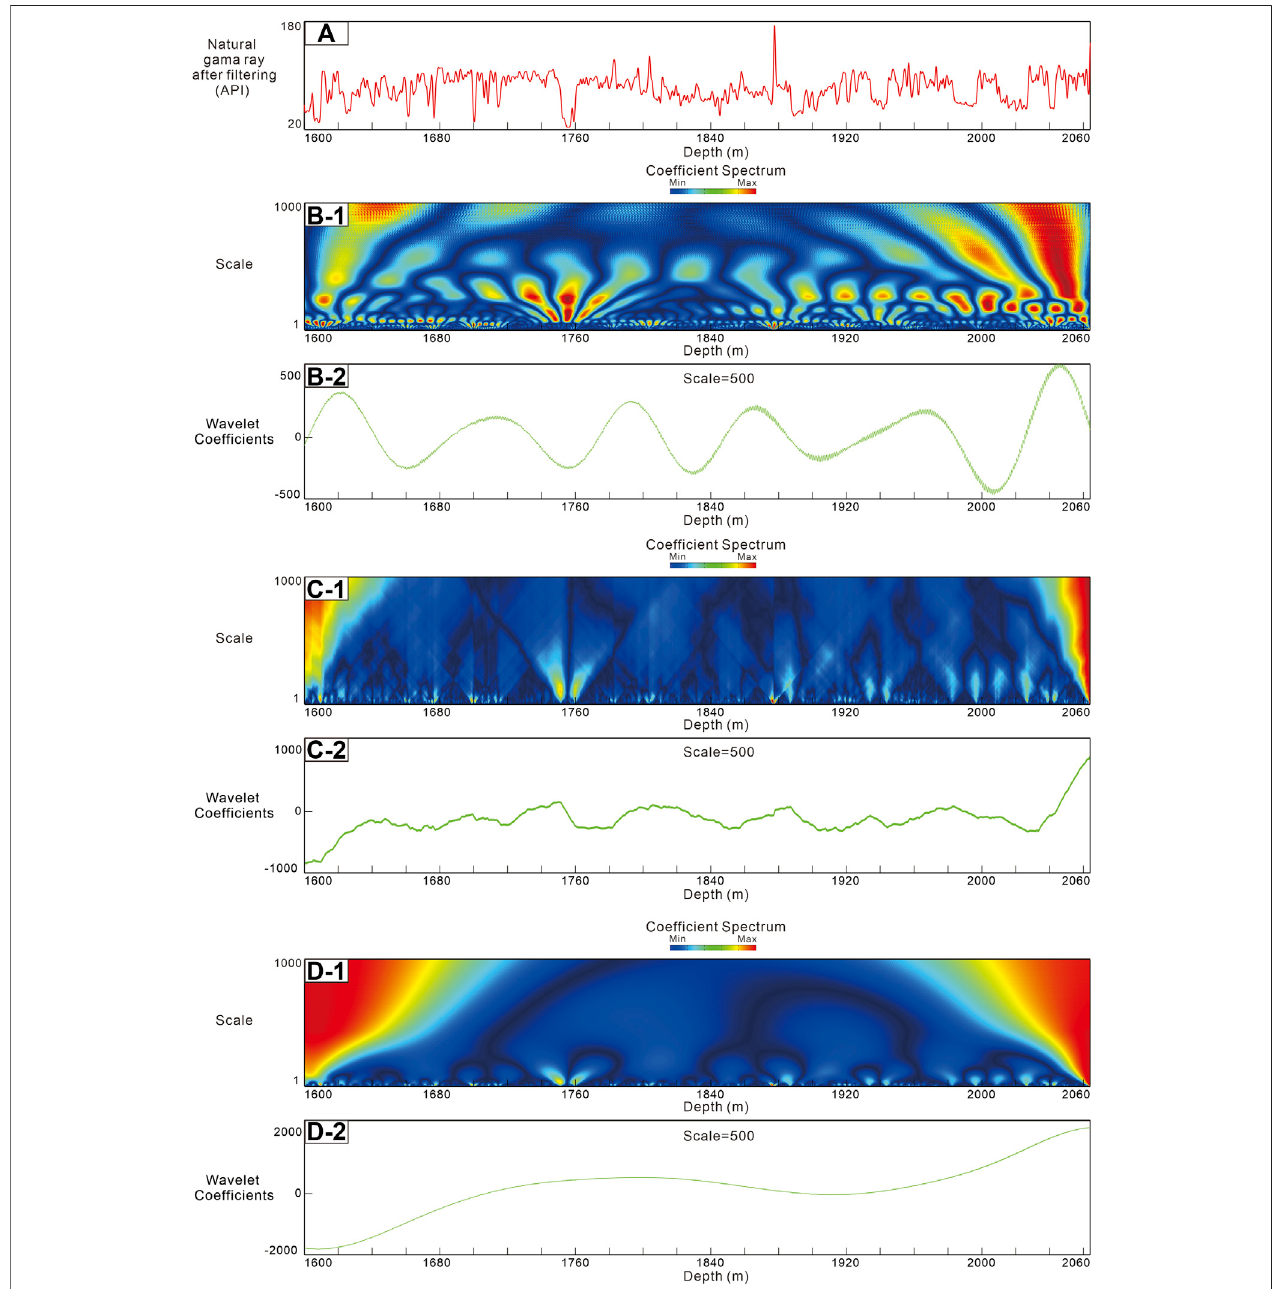
FIGURE 14 | (A) GR curve; (B-1) : Energy spectrum of CWT based on Morlet wavelet; (B-2) : Wavelet coef fi cient curve of CWT based on Morlet wavelet; (C-1) : Energy spectrum of CWT based on Haar wavelet; (C-2) : Wavelet coef fi cient curve of CWT based on Haar wavelet; (D-1) : Energy spectrum of CWT based on Gaussian wavelet; (D-2) : Wavelet coef fi cient curve of CWT based on Gaussian wavelet.